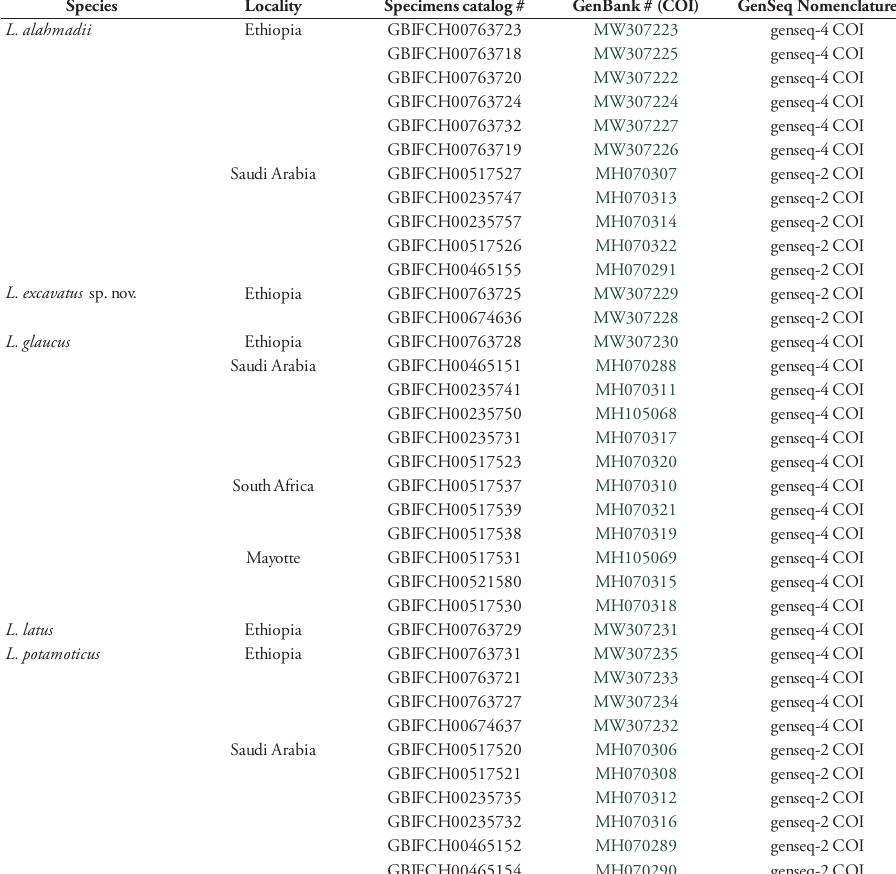
Table 1. Sequenced